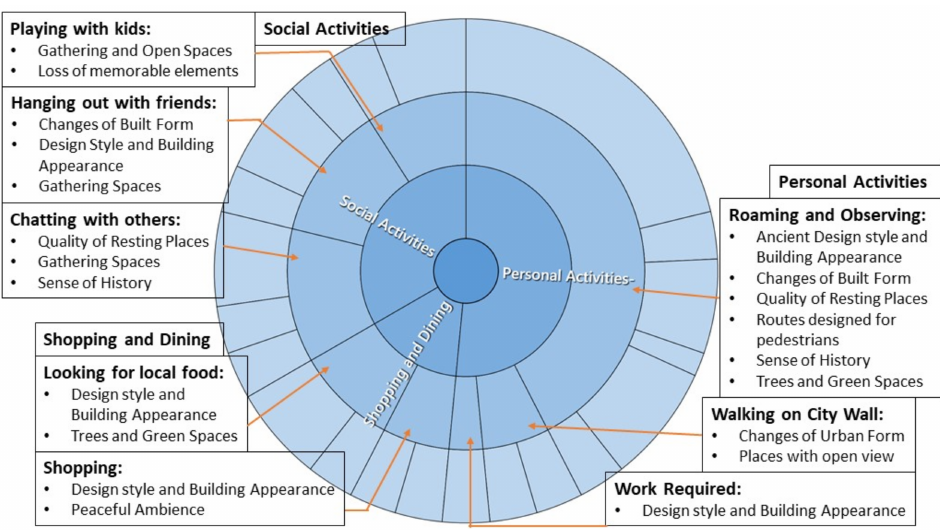
Figure 8. Results and categories of on-site locals’ responses—activities and influential